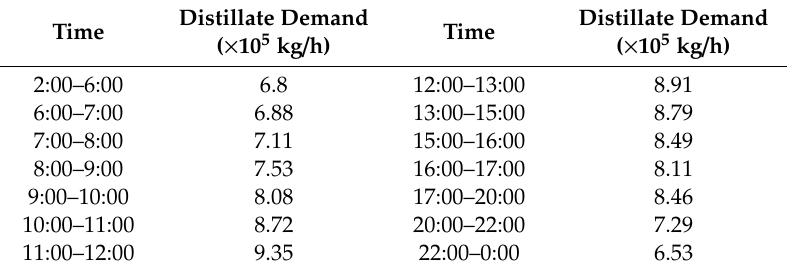
Table 5. Distillate demand in each time